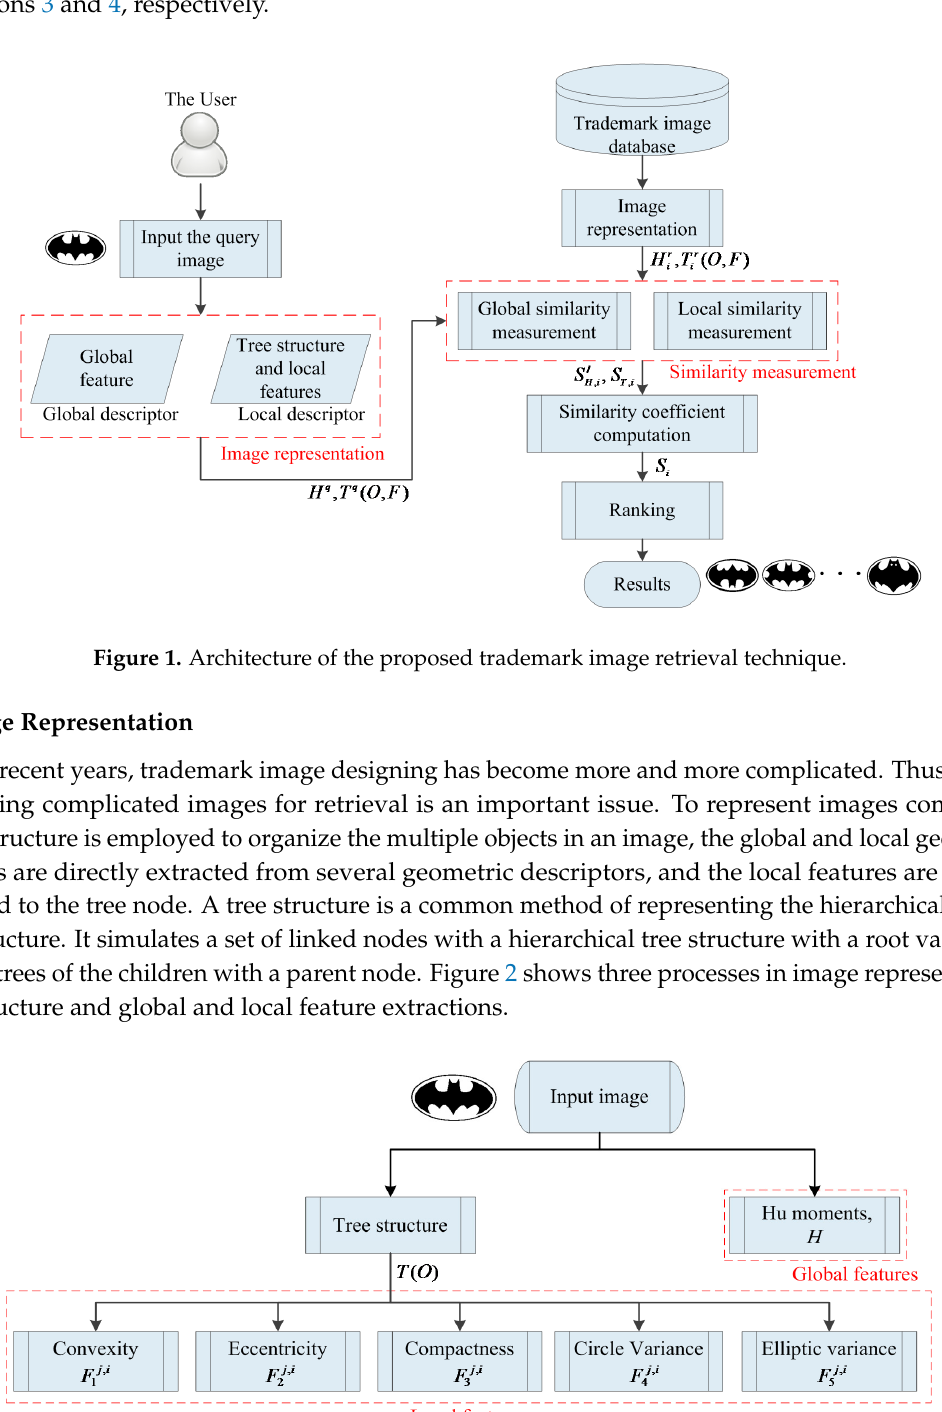
Figure 2. Three processes in image representation.